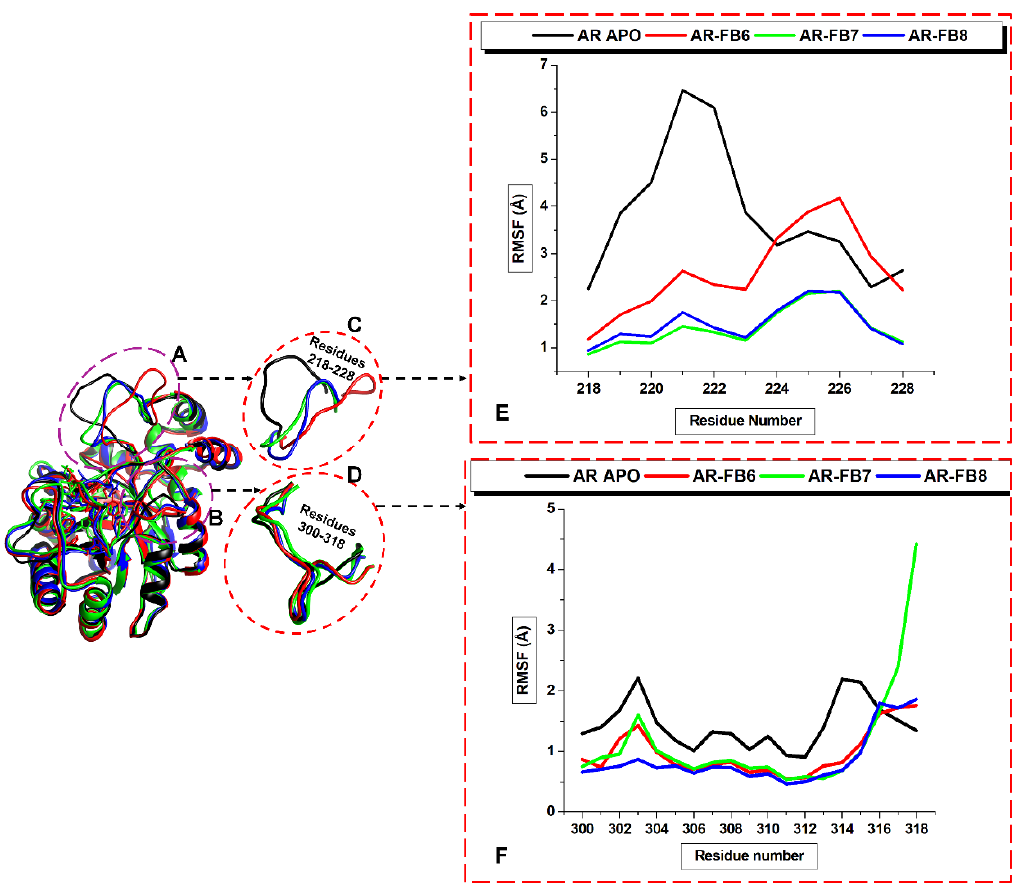
Figure 10. Loop dynamics plot for residues 218–228 ( A ) and 300–318 ( B ). Zoomed-out snapshots of the loops A ( C ) and loop B ( D ). RMSF of the superimposed Apo and the bound ALR2 systems to show loop A ( E ) and loop B ( F ).